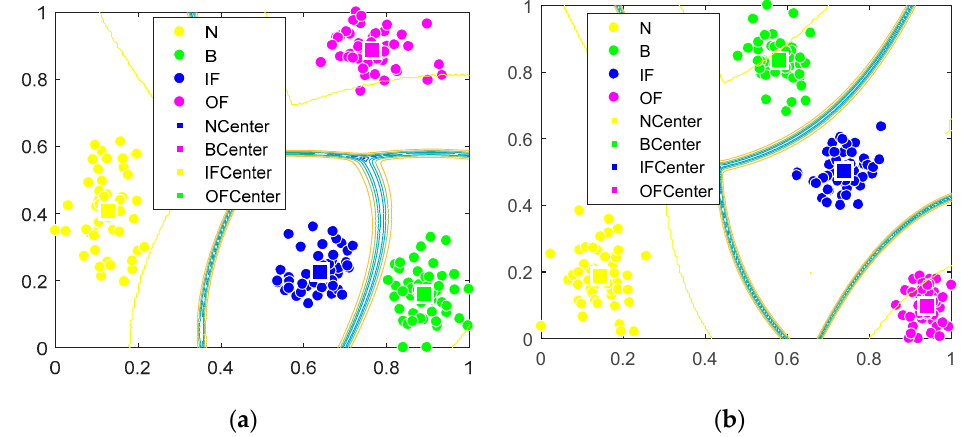
Figure 8. ( a ) The GG clustering contour for SE. ( b ) The GG clustering contour for FE.